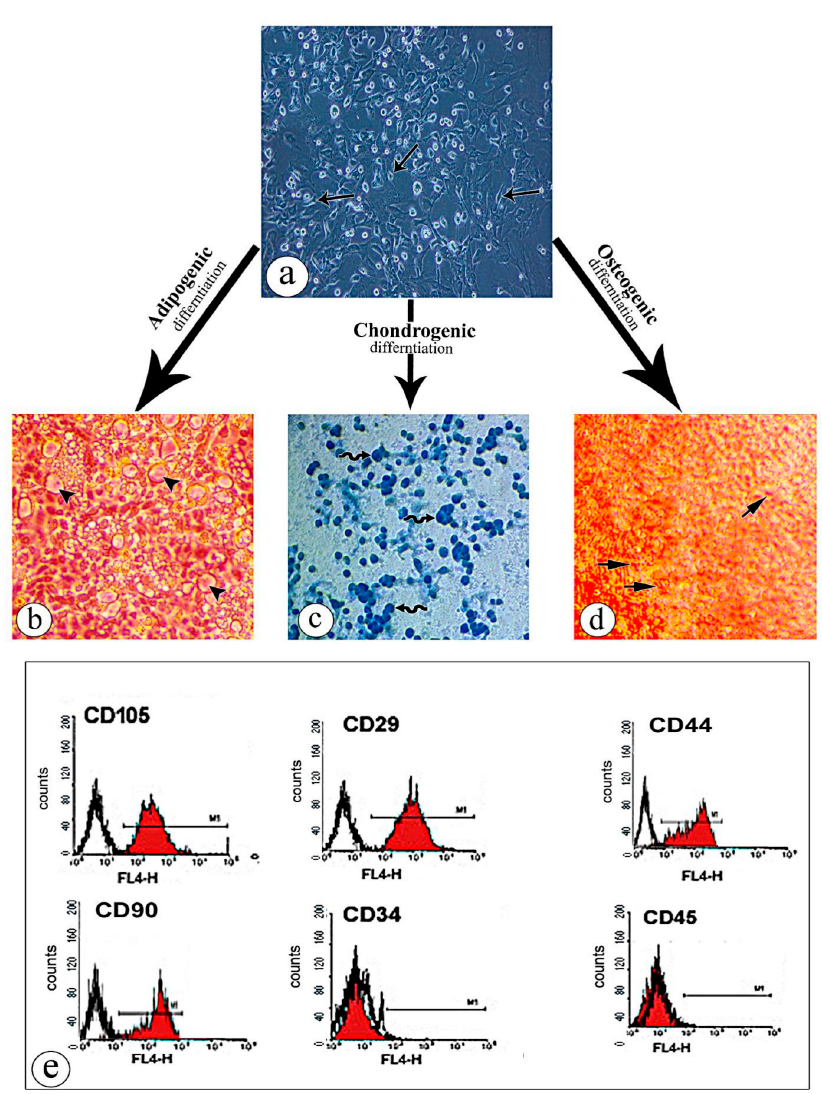
Figure 1. Characterization of bone marrow-derived mesenchymal stem cells: ( a ) the adherent cells appeared fusiform in shape with an elliptical nucleus (arrow); ( b ) BM-MSCs differentiated into adipocytes and stained with Oil Red O exhibited intense cytoplasmic staining, signifying the accumulation of lipid vacuoles (head arrow); ( c ) BM-MSCs differentiated into chondrocytes, exhibiting positive Alcian Blue staining (wavy arrow); ( d ) BM-MSCs differentiated into osteocytes and stained with Alizarin red staining, indicating clusters of calcium depositions (thick arrow); ( e ) FACS analysis of isolated stem cells showing that the bone marrow-derived mesenchymal stem cells were strongly positive for CD105, CD29, CD44, and CD90 markers but negative for CD34 and CD45